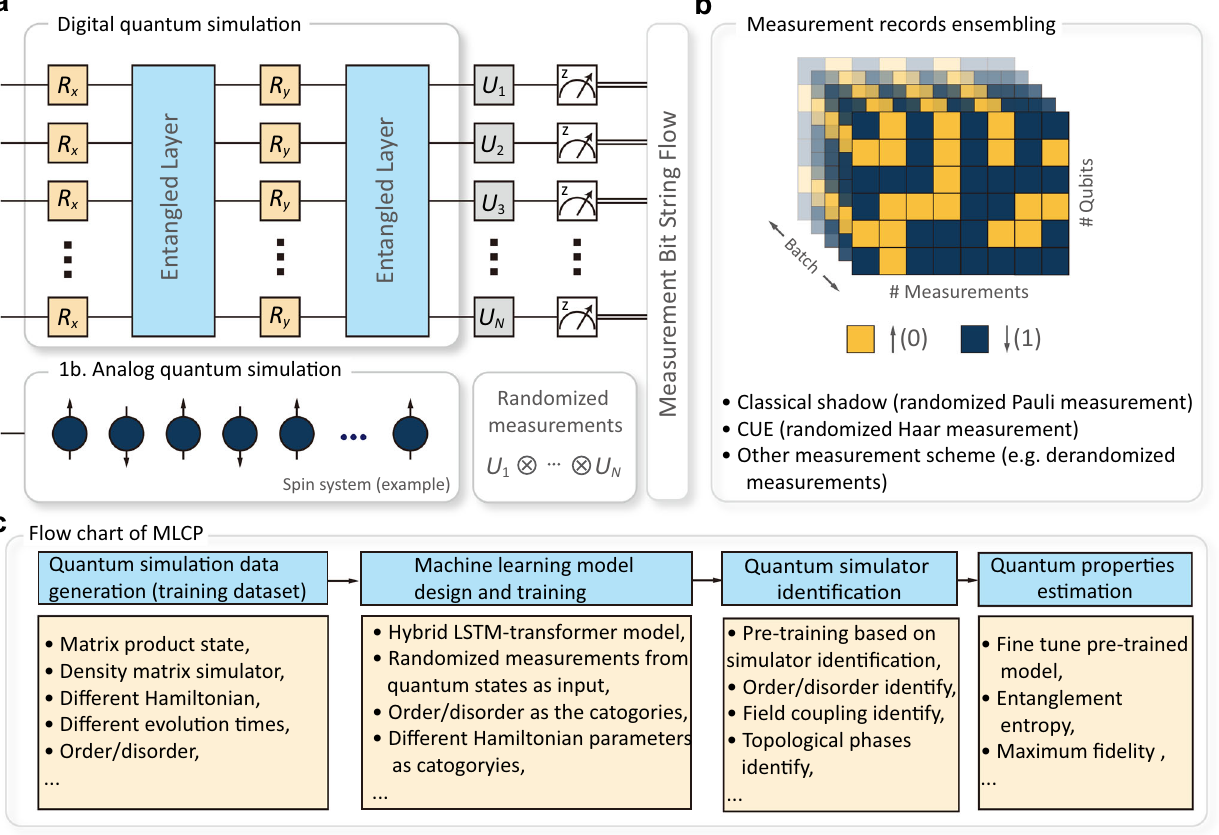
Fig. 1 Ab initio end-to-end machine-learning certi fi cation protocol (MLCP) for quantum simulation machines (QSMs). a The digital quantum evolution represented by variational quantum circuit, or the analog quantum evolution such as quantum Ising spin model or Bose – Hubbard model is prepared. Both two evolutions adopt randomized unitaries to collect the measurement records. b Reshaping the measurement records and concatenating them into one batch computational tensor. Each row denotes records of the total number of measurements repeated for one qubit. Each column represents the full-size qubit records with single-shot measurement. c The fl owchart of MLCP works. Our protocol consists of four procedures: quantum simulation data generation, machine-learning design and training, quantum simulator identi fi cation, and properties estimation. For the large-scale quantum simulation in classical computers, matrix product states are highly suitable for simulating states with entanglement entropy growth limited to log D with D denoting the maximum bond